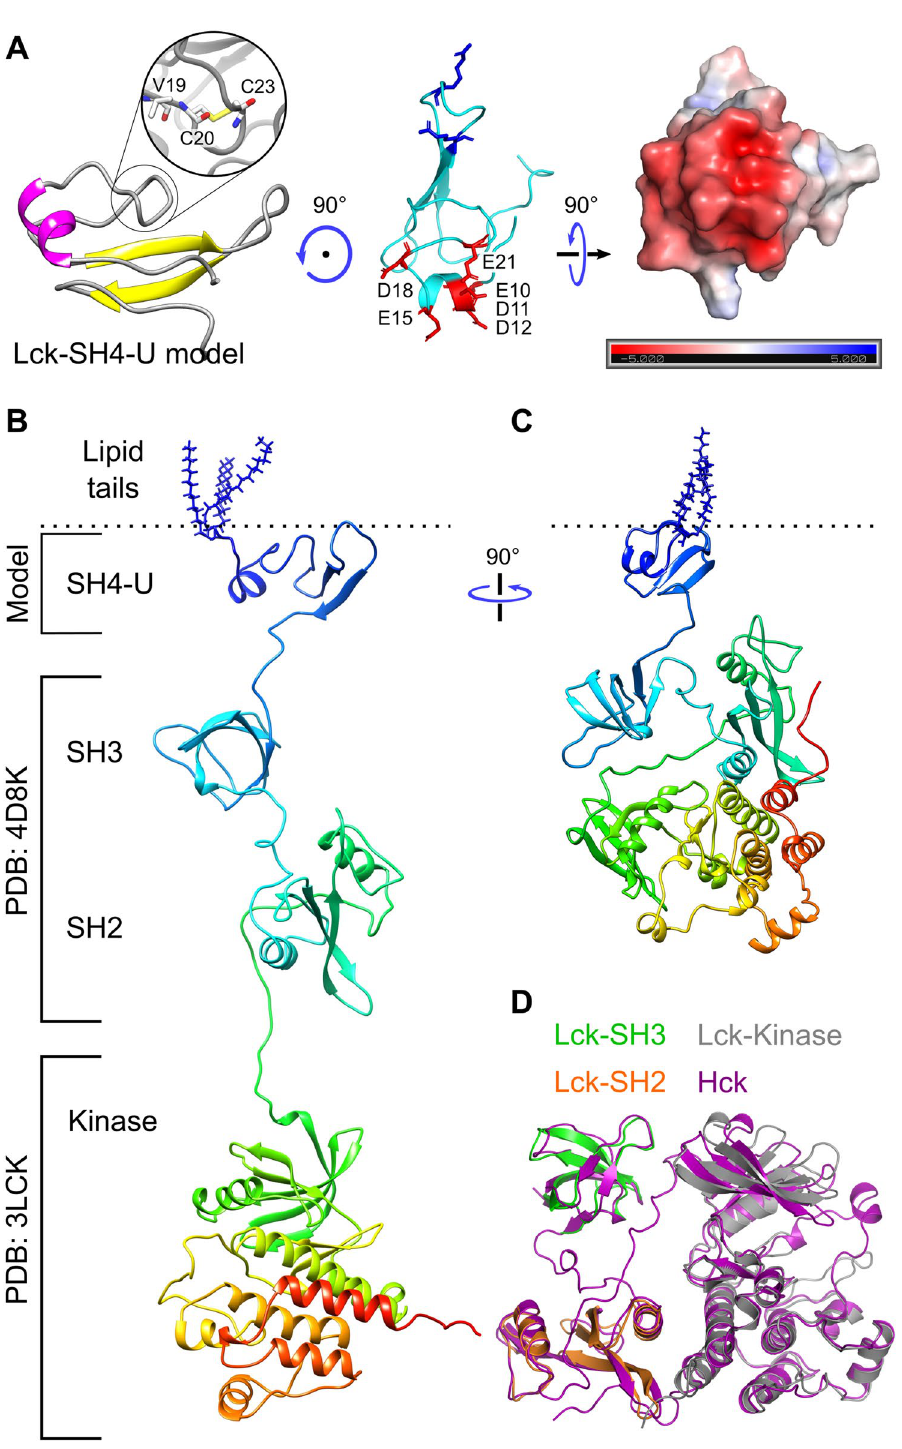
Figure 1. Model of the SH4-U domain and, the open and closed full-length Lck conformations. ( A ) The model of the SH4-U domain (residues 2 to 63) used in this study. The region responsible for coordinating a Zn 2+ ion is magnified (left). Residues forming the anionic patch in our model are shown as red sticks and labelled. PIP lipid binding cationic residues (R39, R45), as suggested in this study, are shown as blue sticks are located on the opposite side of the anionic patch (middle). The electrostatic profile of the anionic patch (right) shown was calculated in the ± 5 kT/e range and at pH 7.0 using the PDB2PQR 38 and APBS 39 tools. Electronegative and electropositive regions are indicated by red and blue intensities respectively. (B) The model of the open Lck-FL conformation and (C) the closed Lck-FL conformation used in this study. (D) Isolated SH2, SH3 and kinase domains aligned to the closed state of Hck (PDB:5H0B) 34